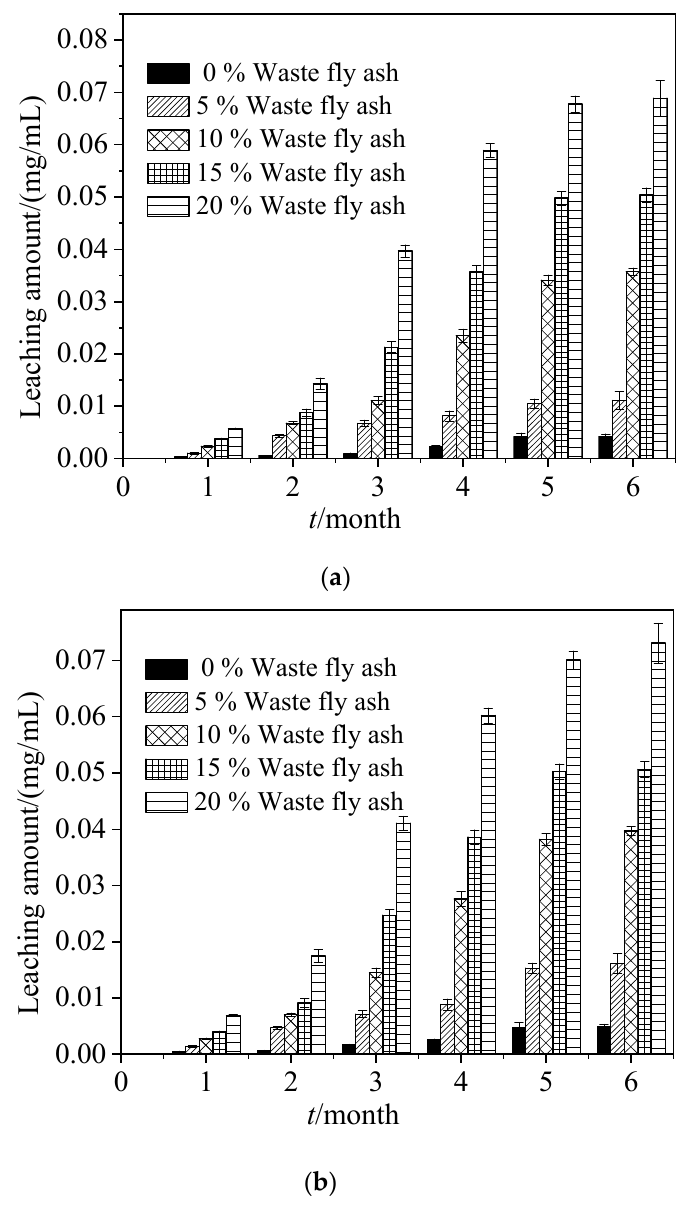
Figure 9. The leaching amount of toxic metal elements: ( a ) Cr; ( b ) Zn. Scanning electron microscopy (SEM) was then adopted to investigate the influence of WFA on the microstructure of hydrated RPC. Figure 10 shows SEM images of RPC with 0% and 10% WFA cured in the standard curing condition and an environment of 40 °C and a 95% relative humidity. As shown in Figure 10a, a large number of acicular hydration products were observed in the specimen with 0% WFA after curing in the standard curing environment for 1 day. However, the fraction of needle-like products decreased, and the hydration products became more compact when 10% WFA was added into the RPC. Moreover, when cured at a higher curing temperature, the needle-like hydration products in specimens with 0% WFA gradually connected into a network of hydration products (shown in Figure 10c). As shown in Figure 10d, the addition of WFA could effectively increase the compactness of hydration products due to the improved hydration process by WFA. Figure 10e shows the control specimen cured for 28 days; it can be observed that the microstructure of RPC was compact and consisted of a large number of flocculent hy- dration products. Comparing Figure 10e and Figure 10f, the addition of WFA improved the compactness of the hydration products, which indicates that the WFA was beneficial to the microstructures of RPC with improved durability. ( a )